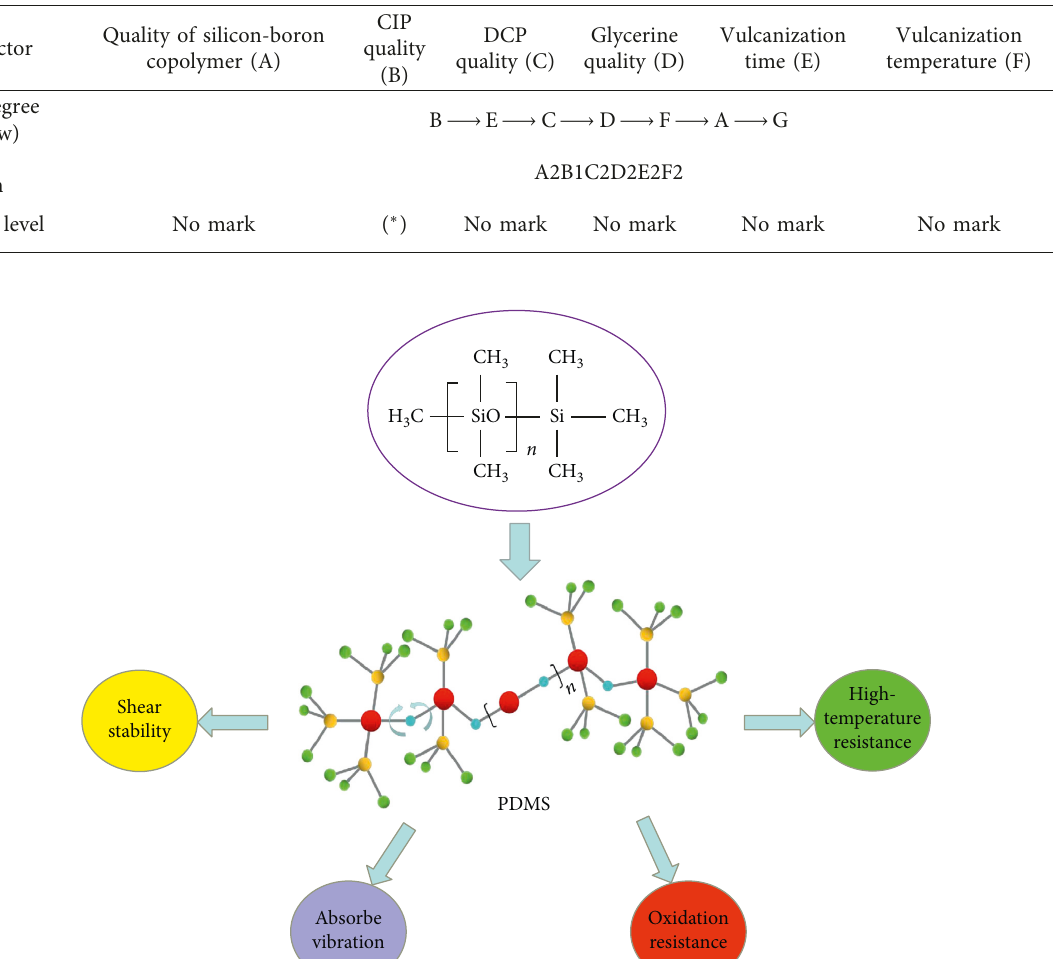
Table 5: The range analysis and variance analysis of the RME.